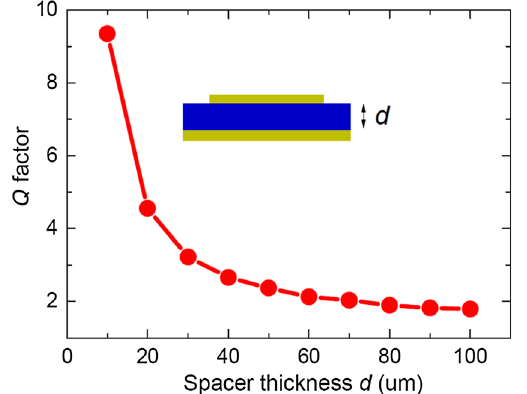
FIG. 11. Q factors as a function of the spacer layer thickness. All materials in the metasurface are assumed to be dissipationless. The geometry of the Al mesa layer is identical to the geometry shown in Fig. 4, and only d is varied.